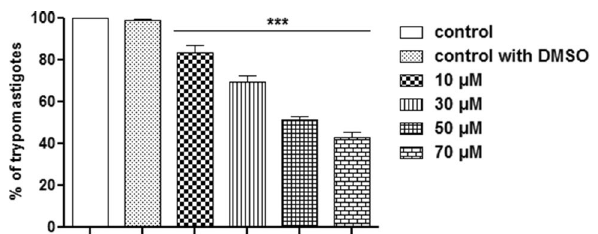
Figure 3. Trypanocidal effect of FEX against trypomastigotes after 24 h. The number of parasites was reduced in a dose-dependent manner. The data are the average of three independent experiments in triplicate (***p <